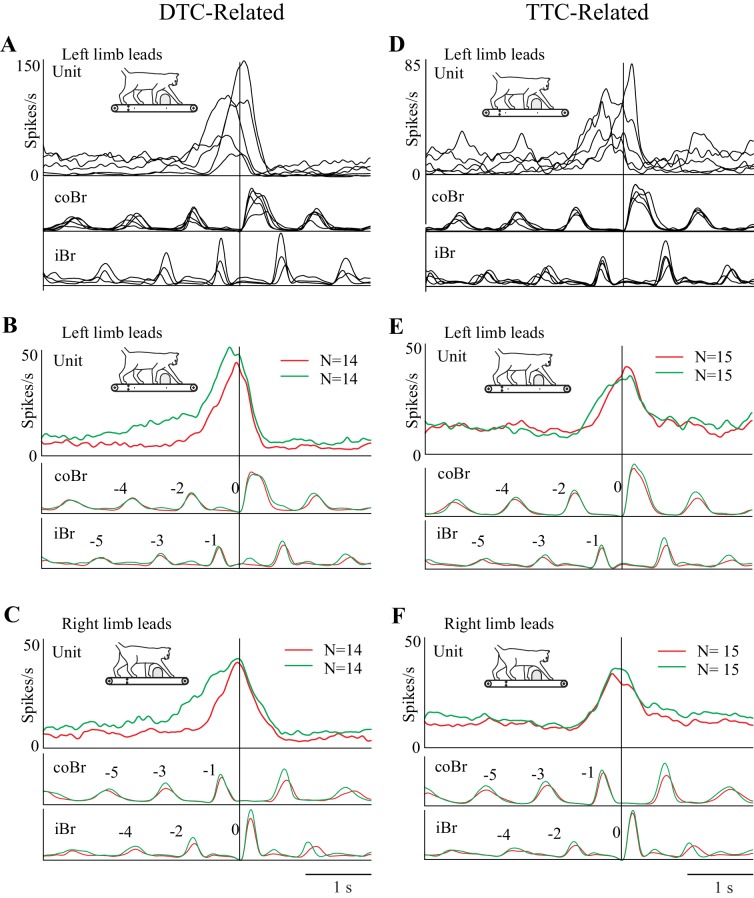
Relationship of cell discharge onset to distance and time (population averages).(A,D) Five example cells illustrating that the changes in cell discharge in the different populations begin at staggered times preceding the step over the obstacle. Cell discharge patterns taken from the matched condition and aligned to the onset of the Br. Cells scaled to the cell with the highest discharge rate in each illustrated group of cells. (B,C) Average discharge activity of the 14 DTC cells during left (B) and right (C) lead conditions. (E,F) Average discharge activity of the 15 TTC cells during left (E) and right (F) lead conditions. Data in B,C,E,F are shown for the matched (red traces) and visual dissociation (green traces) task. All traces are scaled identically in (B,C) and (E,F). Figure 6—figure supplement 1: Additional Population Averages.